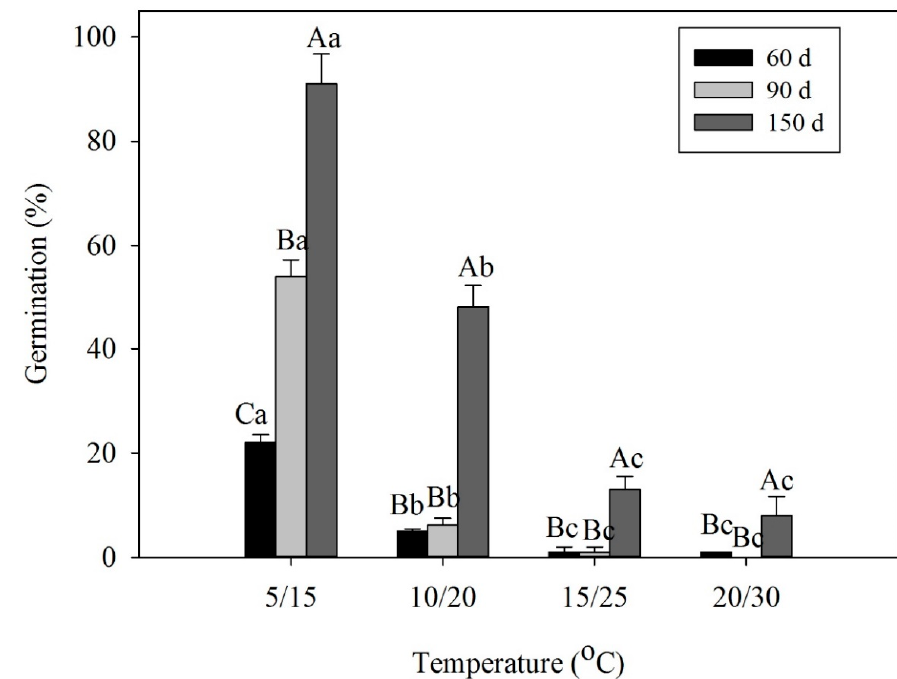
Figure 3. Effects of cold stratification on germination of Sorbus alnifolia (Siebold & Zucc.) K.Koch seeds. Error bars are mean ± se. Different uppercase letters indicate significant differences among temperatures at the same cold stratification time, and different lowercase letters indicate significant differences among different cold stratification times at the same temperature ( p < 0.05).